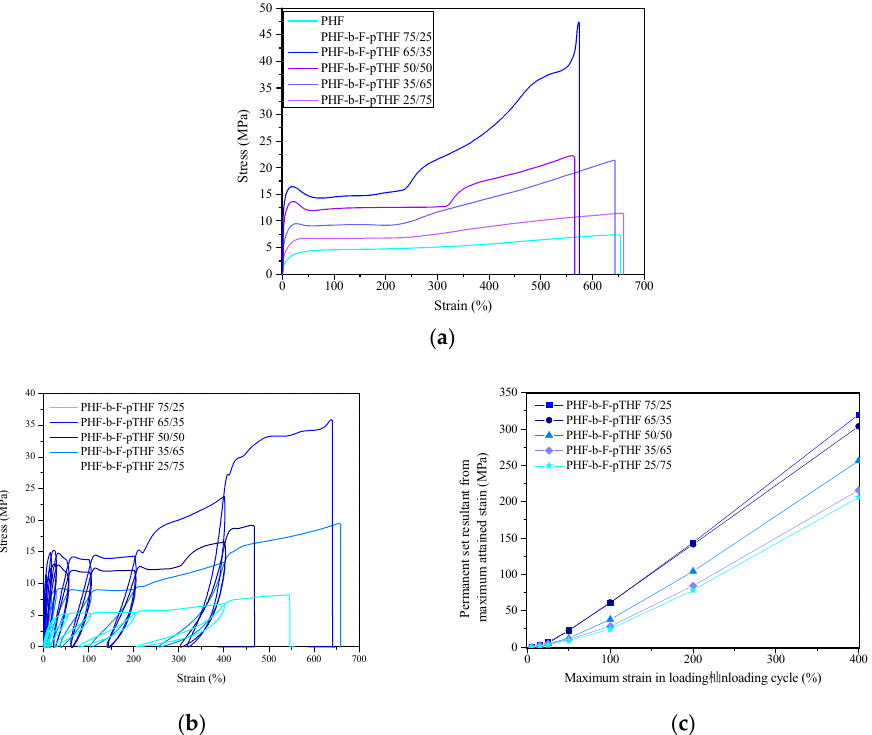
Figure 9. Representative stress–strain curves for PHF- b -F-pTHF copolymers from ( a ) static tensile tests, ( b ) cyclic tensile tests, and ( c ) permanent set results after following deformation cycle.